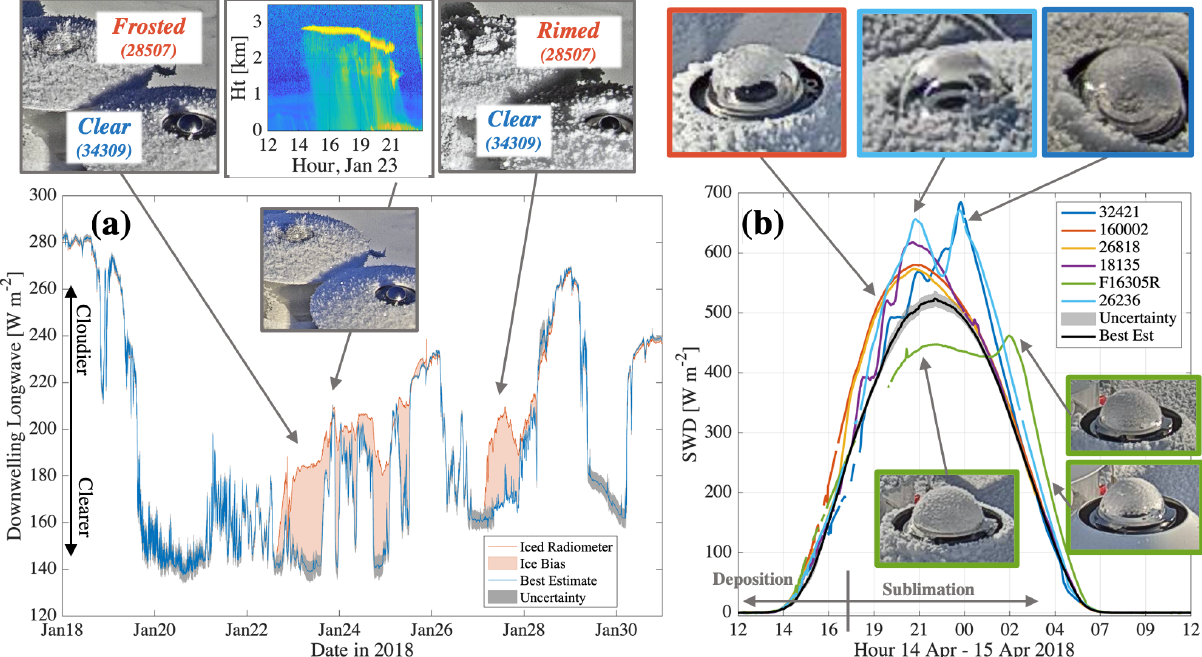
Figure 4. Case studies of icing for LWD in late January (a) and SWD during a clear day in April (b) . Inset images show the condition of highlighted radiometers. The upper-center panel in (a) shows backscatter from the DoE-ARM